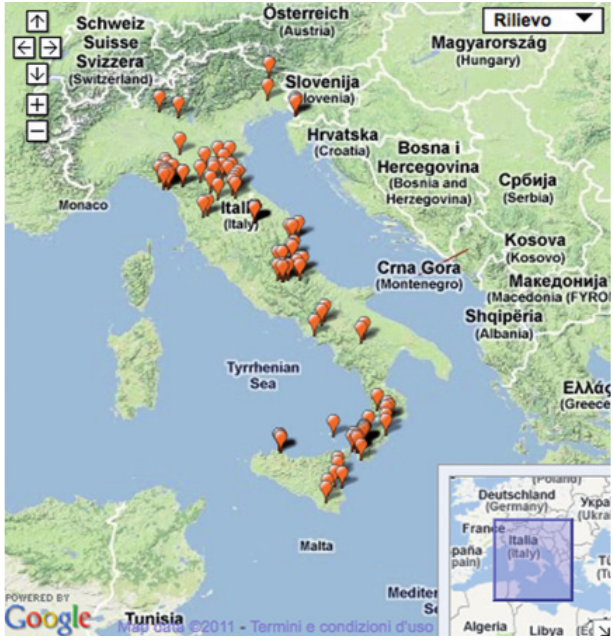
Figure 4. Geographical distribution of the schools involved in the EDURISK